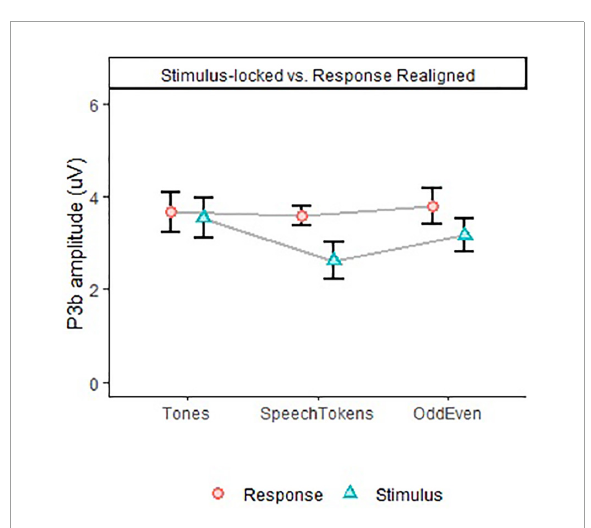
FIGURE6 P3b amplitude for all three tasks in Experiment 2, depicting differences in task effect on stimulus and response aligned data. Error bars represent standard error of the